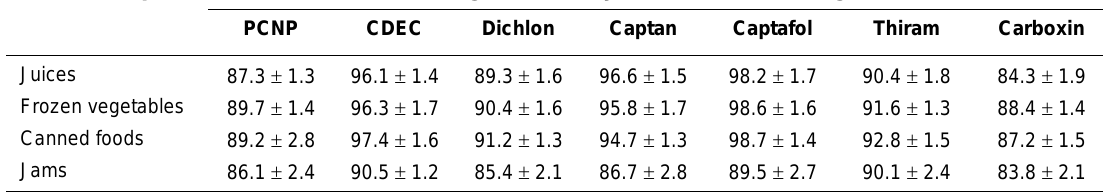
Fungicide Recovery and RSD Percentages of Spiked Food Samples Extracted by SFE and Determined by SFC/UVD at 210